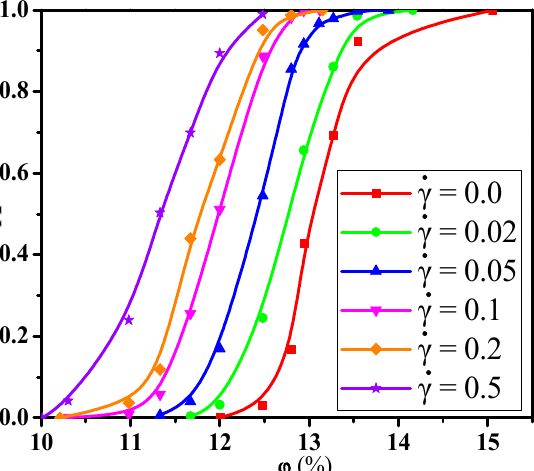
Figure 9. Snapshots of the largest clusters at two shear rates 𝛾 (cid:4662) = 0.0 and 0.1 for different ratio (